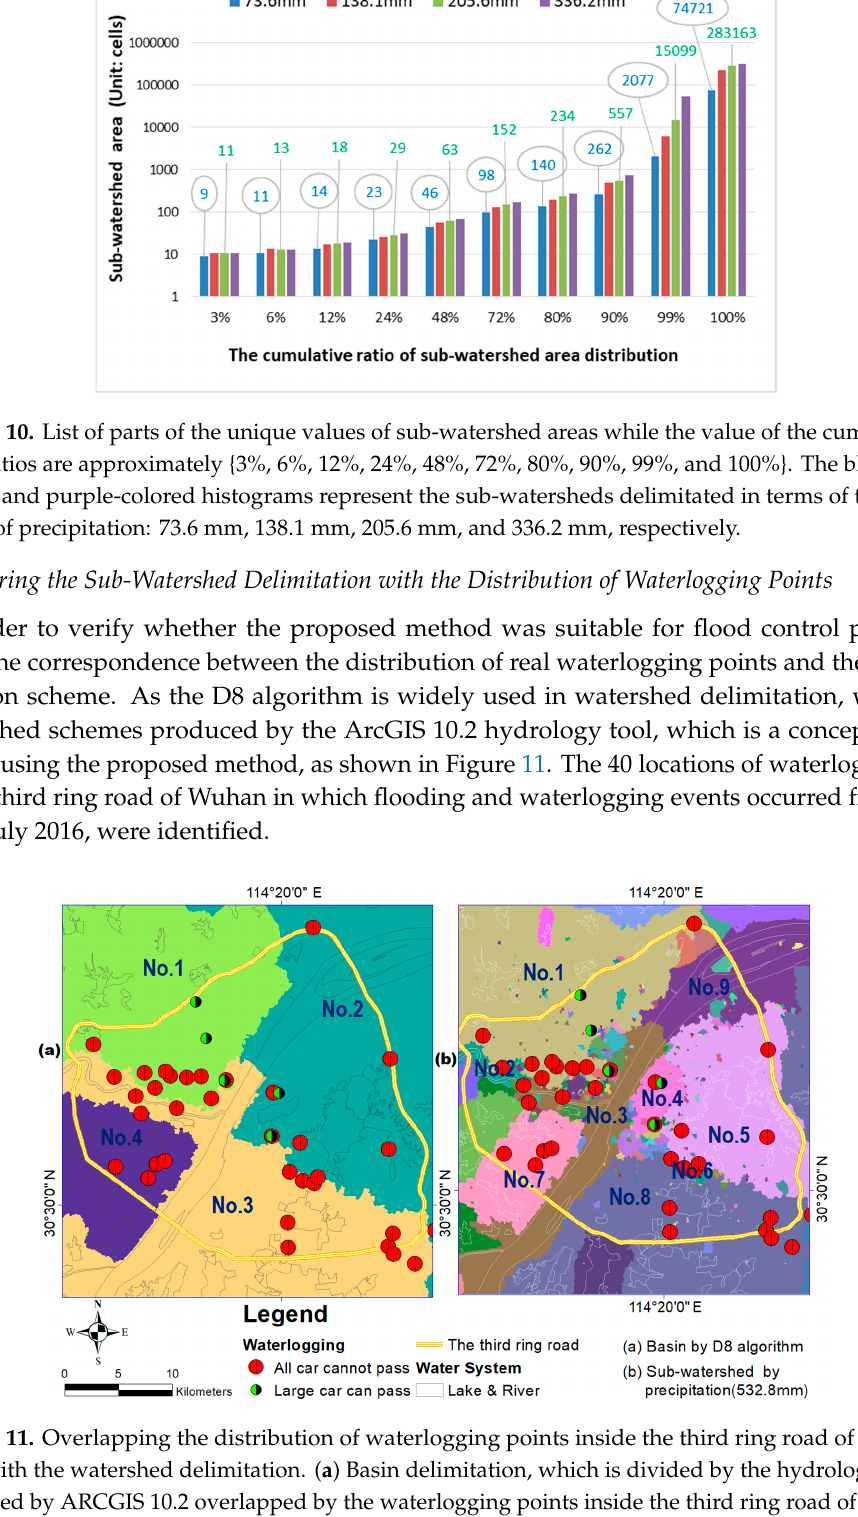
City, and ( b ) is the waterlogging points overlapped with the watershed delimitation by the proposed